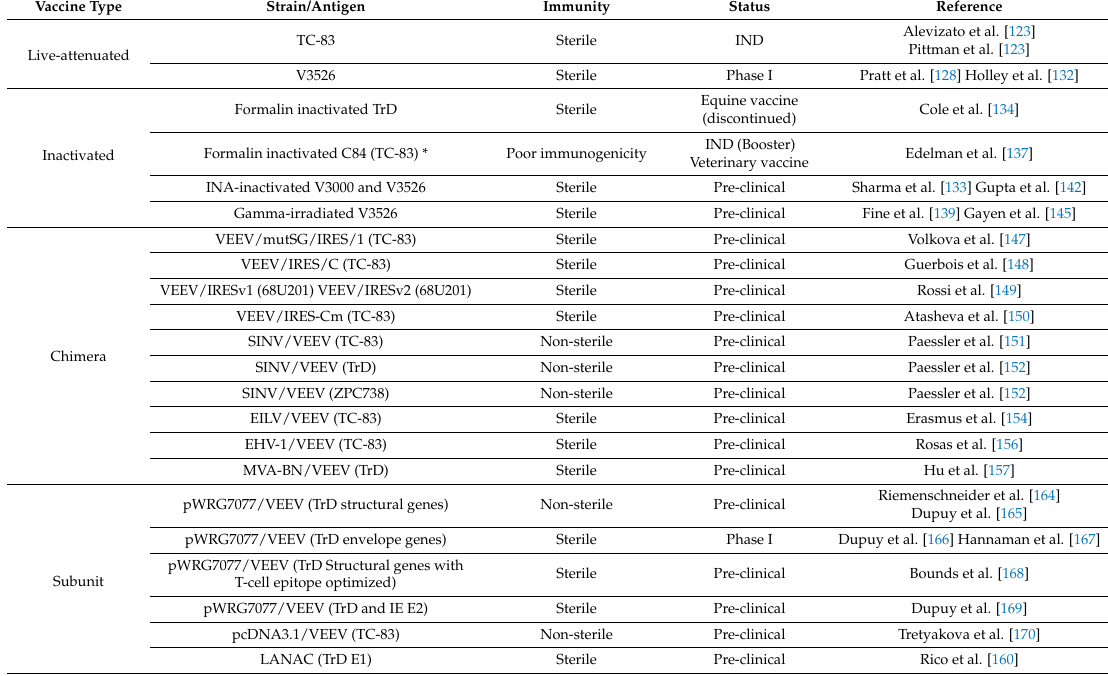
Table 2. VEEV vaccine